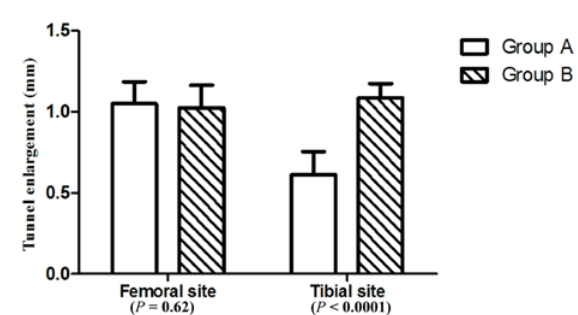
Figure 5: The mean tunnel enlargement (± SD). There was no statisti- cal difference for tunnel enlargement between the two groups at the femoral site ( P = 0.62) but significant difference at the tibial site ( P <